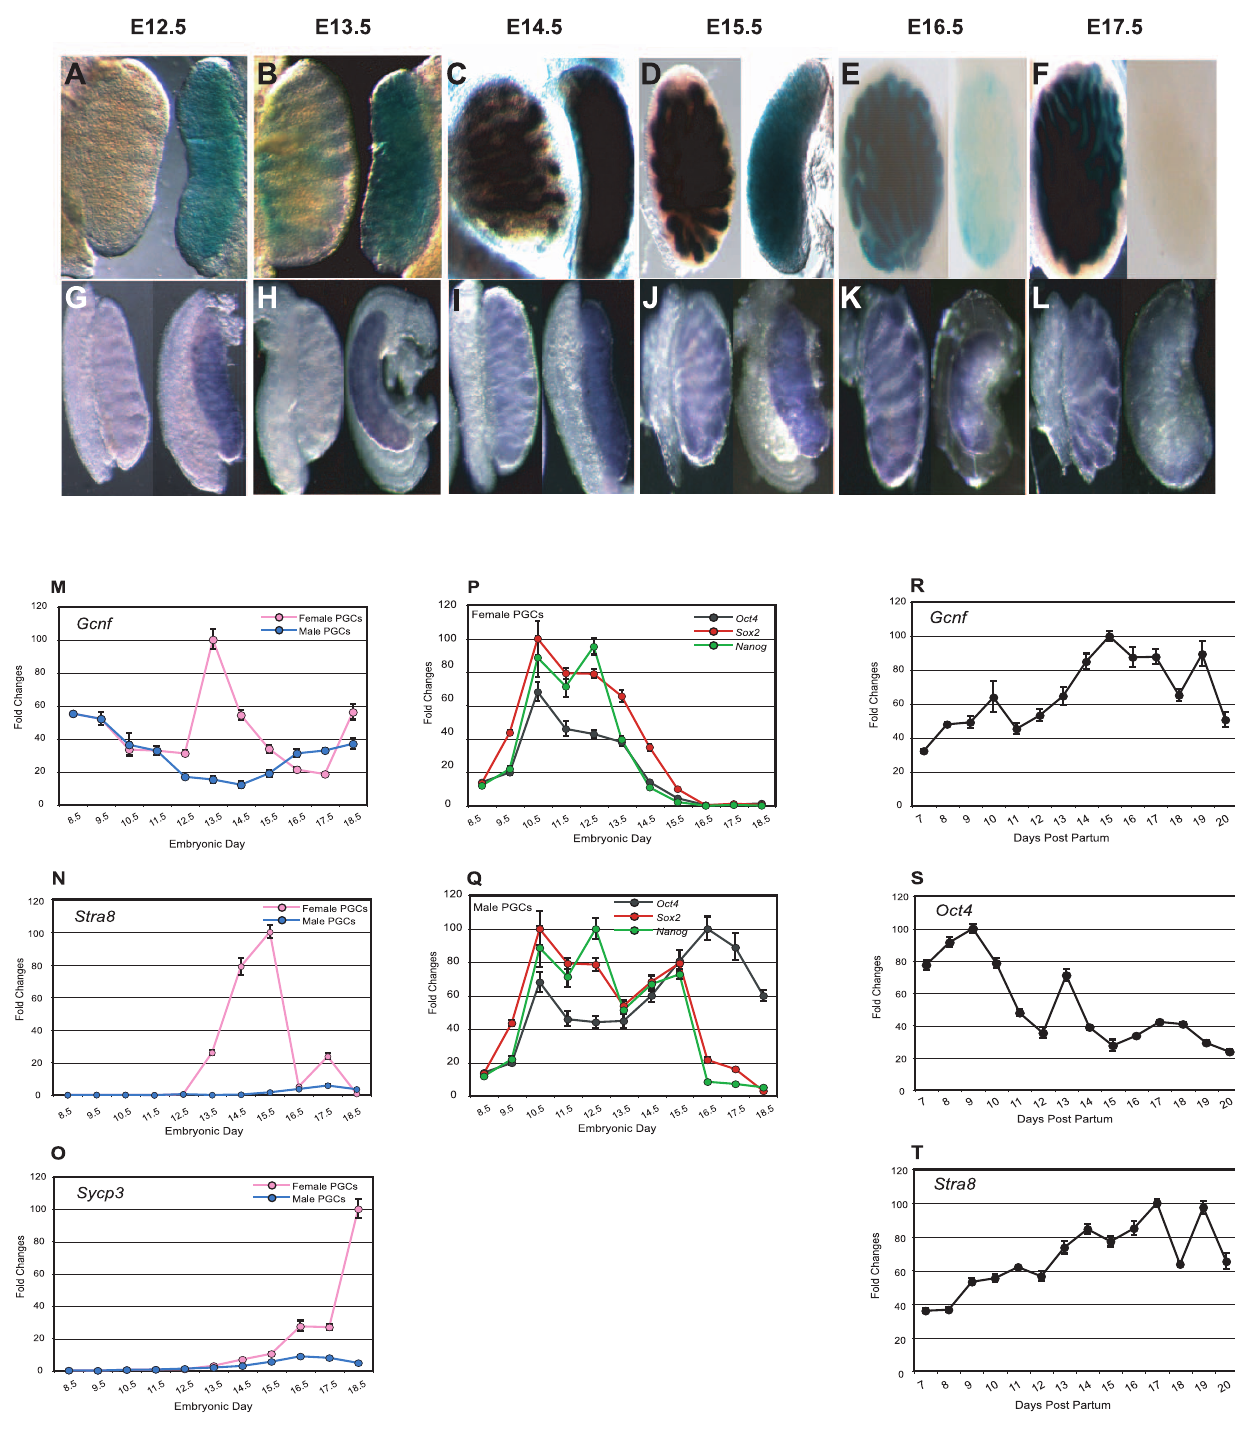
Figure 2. Analysis of Gcnf , pluripotency-associated genes, and meiosis-related gene expression profiles in PGCs in male and female embryonic gonads and in spermatogonial cells. ( A–F ) Analysis of b -galactosidase activity in male (left-hand side of each panel) and female (right-hand side of each panel) gonads in Gcnf LacZ KI embryos on E12.5 to E17.5. ( G–L ) WMISH analysis of Gcnf expression in the gonads of wt male (left-hand side of each panel) and female mice (right-hand side of each panel) on E12.5 to E17.5. ( M–Q ) Time-course analysis of gene expression profiles of PGCs from male and female genital ridges and embryonic gonads. Real-time q-RT-PCR analysis of ( M ) Gcnf . ( P–Q ) Oct4, Nanog , and Sox2 . ( N ) Stra8 , and ( O ) Sycp3 in PGCs isolated by FACS sorting Oct4-GFP–positive cells from the genital ridges (E8.5 to E11.5) and from male and female fetal gonads on E12.5 to E18.5. ( R–T ) Time-course analysis of gene expression profiles of spermatogonial cells in newborn testes. Real-time q-RT-PCR analysis of ( R ) Gcnf . ( S ) Oct4 , and ( T ) Stra8 in spermatogonial cells isolated by FACS sorting Oct4-GFP–positive cells from the testes at 7 dpp to 20 dpp, i.e., during meiosis in male mice.